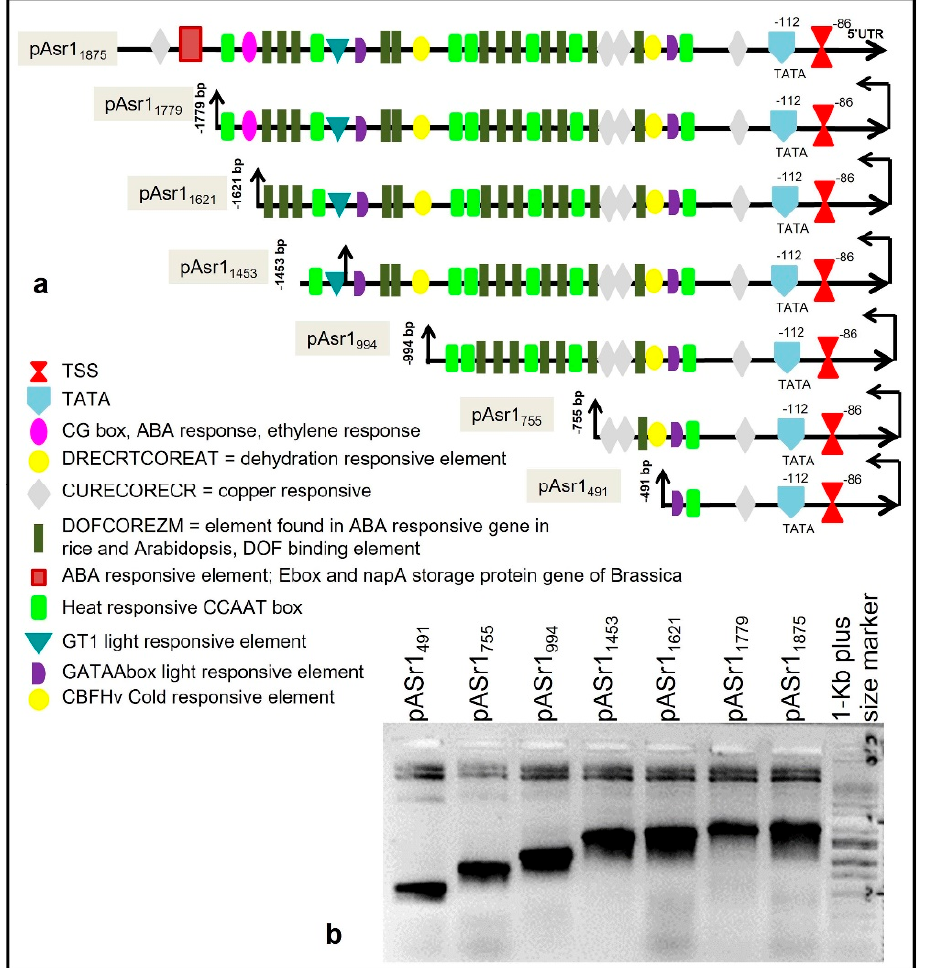
Figure 1. The arrangement of cis-acting motifs on pAsr11875 promoter and their functions ( a ). Several ABA-responsive and dehydration-responsive elements are overrepresented in the promoter. The positions of deletion mutants are highlighted ( − 491 bp– − 1779 bp). ( b ) Gel image showing amplified bands corresponding to promoter deletion fragments that were used to construct gusA fusion vectors.